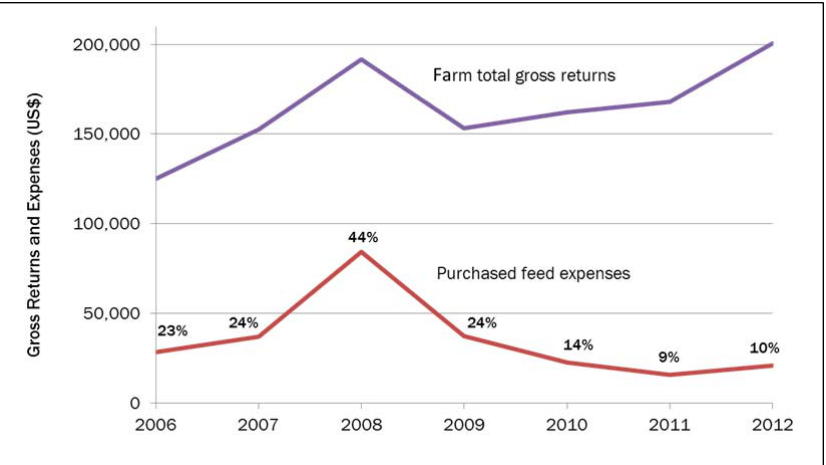
Figure 11. Farm Gross Income and Expenditures (US$) for Purchased Feed in Dollars and as a Percentage of Annual Gross Income,